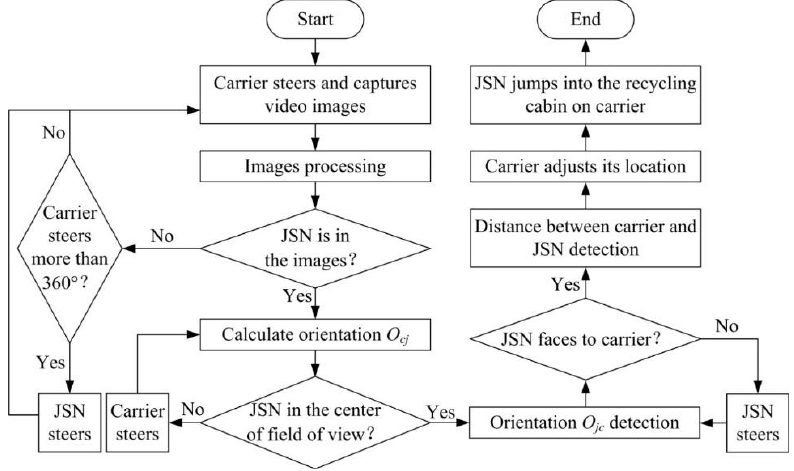
Figure 3. Flow chart of the relative orientations and position detections for JSN recycling.